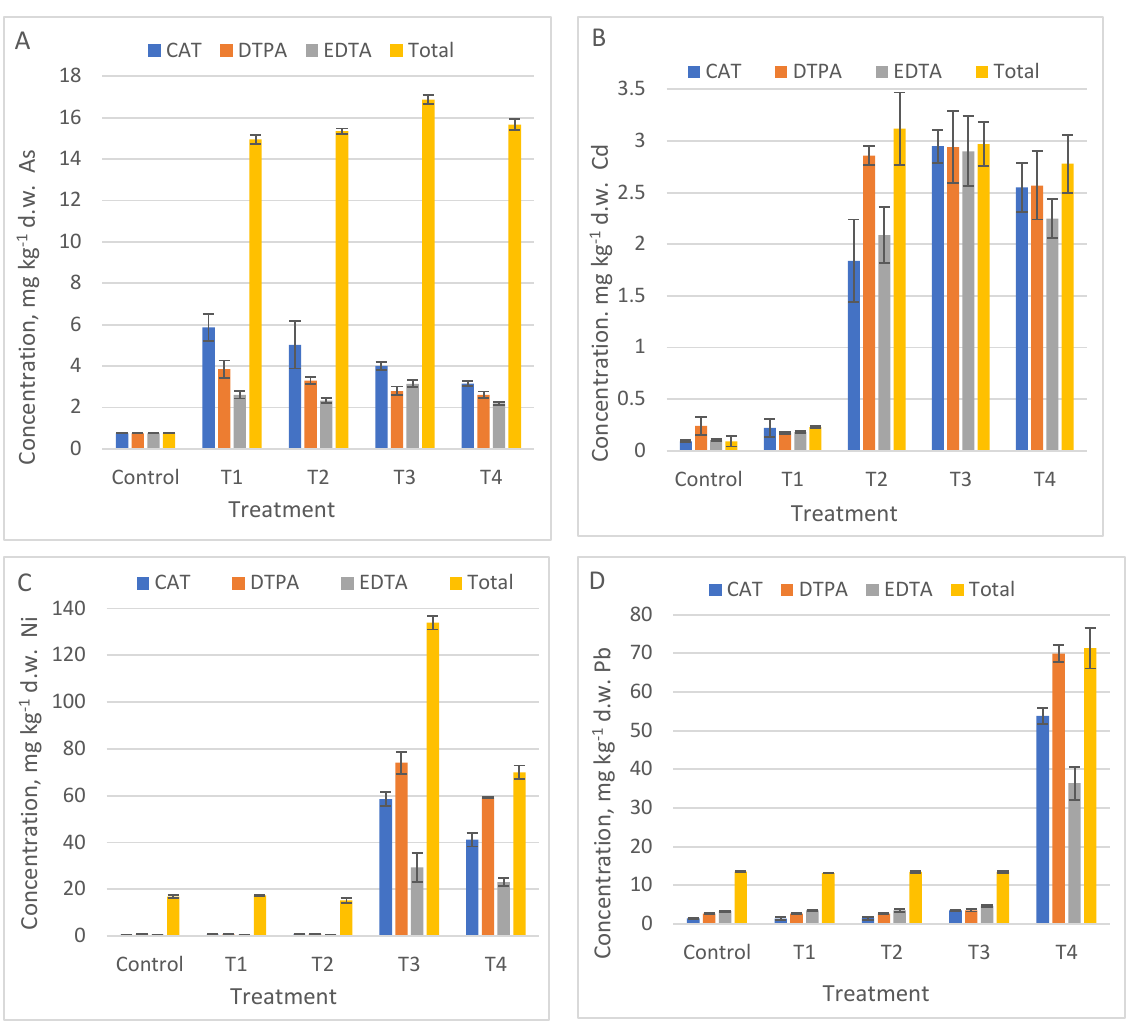
Figure 1. The mobile metallic concentration in Control, and T1 to T4 treatments using three single chemical extraction procedures: DTPA, CAT, EDTA compared to total content, (average ± SD, n = 3): ( A ) As, ( B ) Cd, ( C ) Ni, ( D ) Pb.